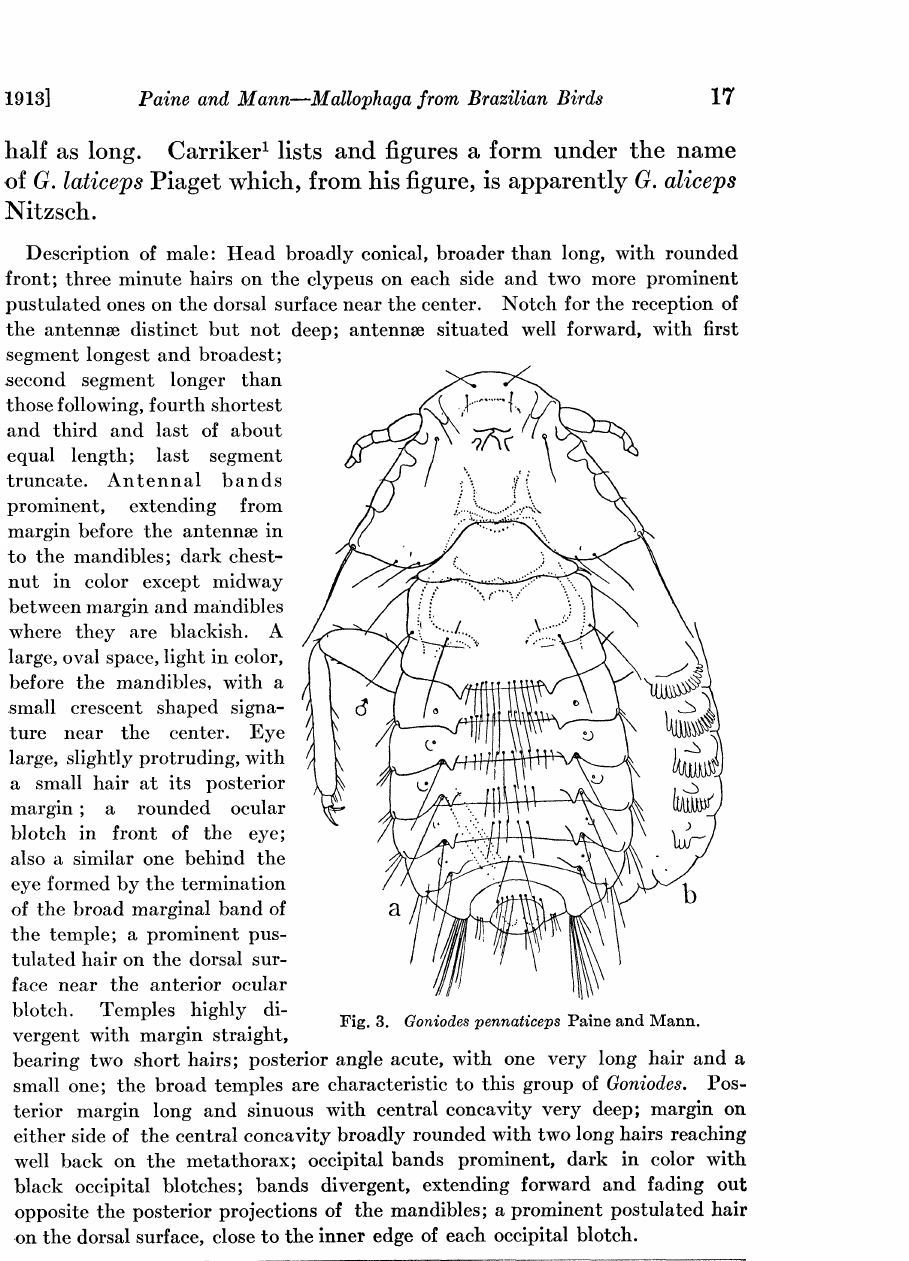
Fig. 3. Goniodes pennaticeps Paine and Mann.